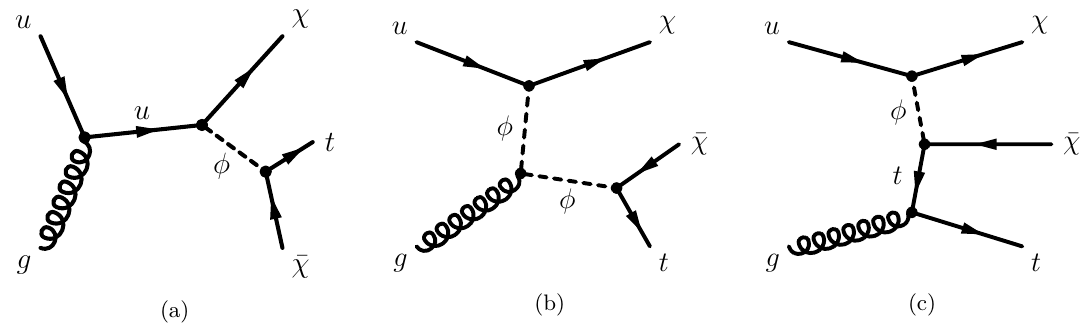
Figure 7 . Representative Feynman diagrams for the production of two dark matter particles χ in association with a single top